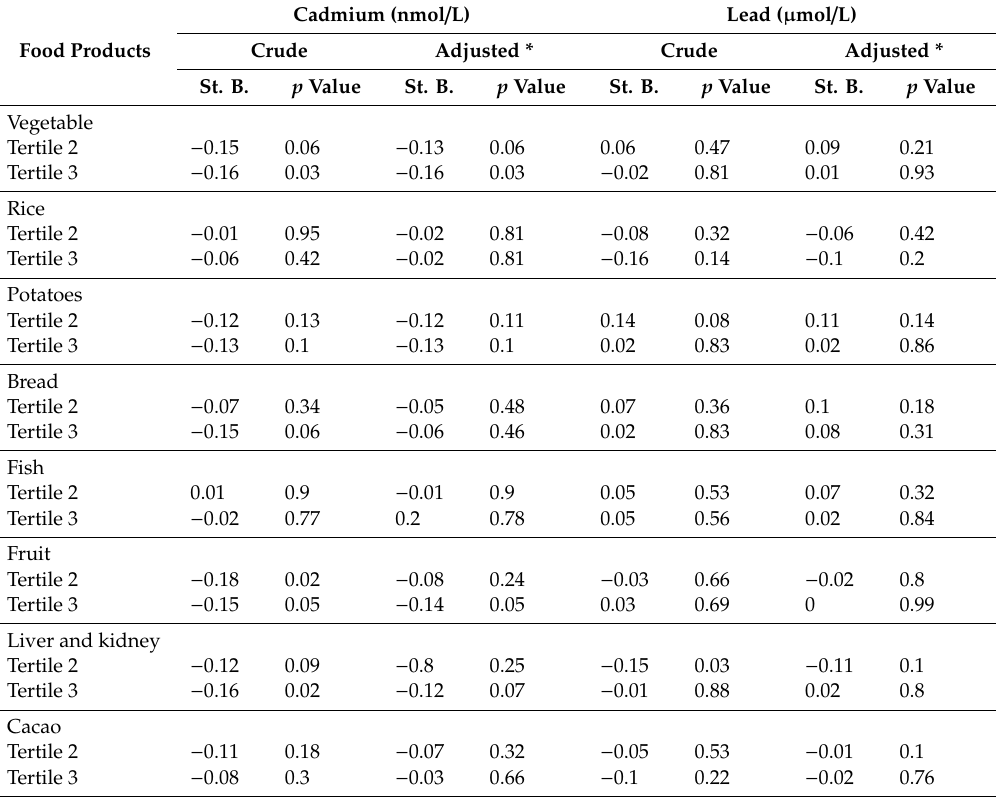
Table 3. Multivariate linear regression between di ff erent food products as independent variables and the Cd and Pb concentrations as dependent variables.